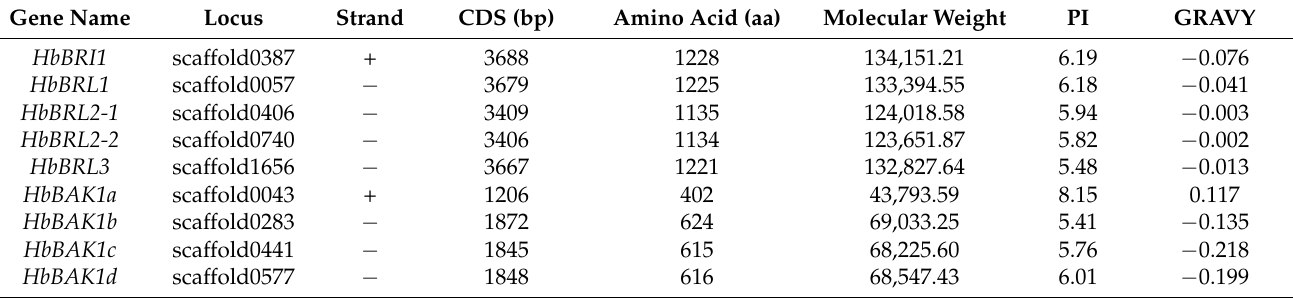
Table 1. Physical and chemical properties of BRI1 and BAK1 genes in the rubber